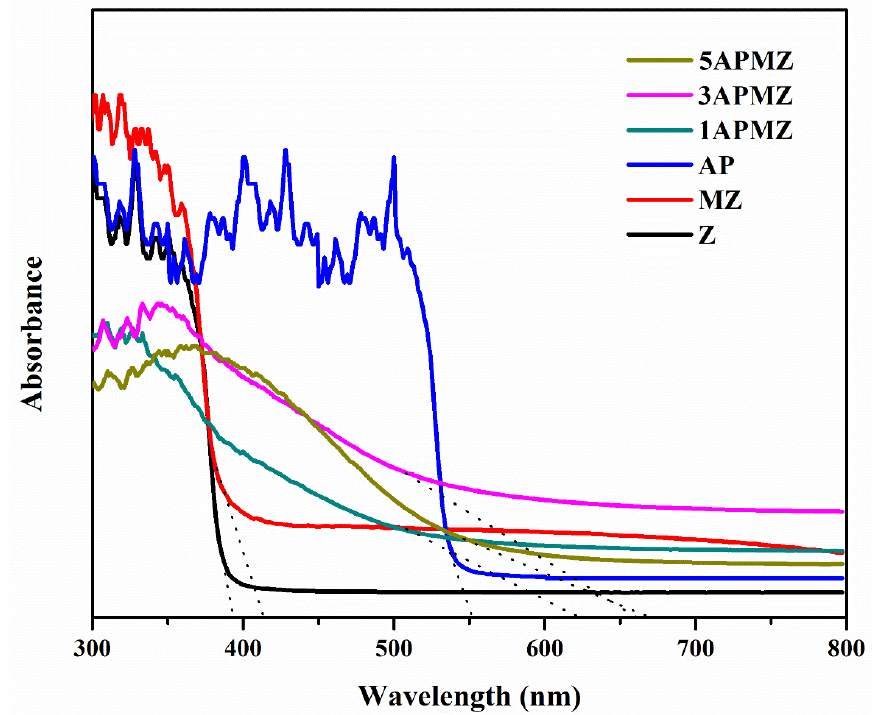
Figure 4. Absorption spectra of Z, MZ, 1APMZ, 3APMZ, 5APMZ, and AP samples. Table 1. The band gap energies comparison among Z, MZ, 1APMZ, 3APMZ, 5APMZ, and AP sam- ples.